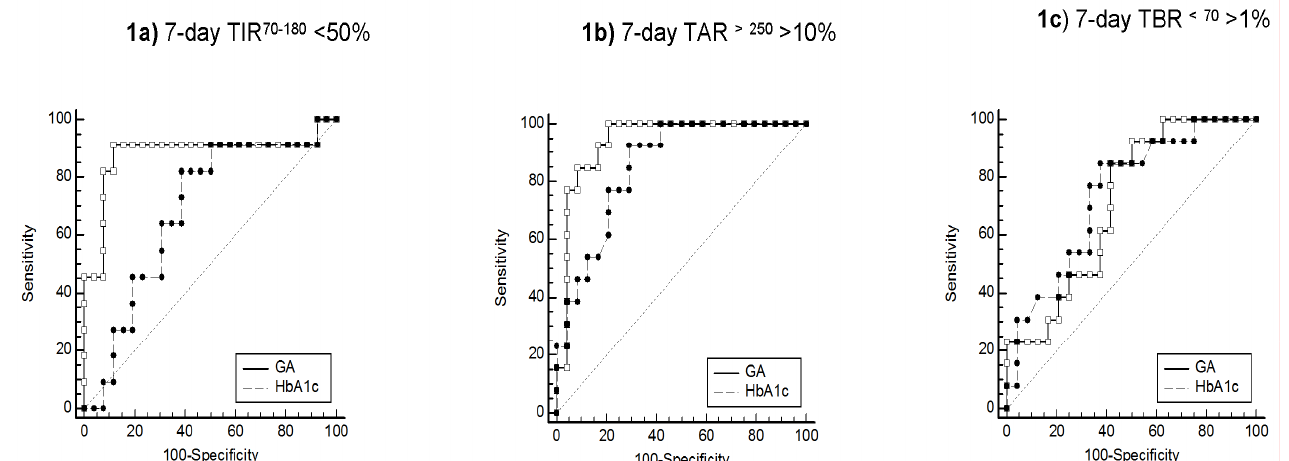
Figure 1. ROC curves of GA and HbA1c in diagnosing inadequate glycemic control using 7-day CGM-derived metrics as the reference standard. Table 2. Thresholds for GA and HbA1c in detecting a 7-day CGM-derived TIR 70–180 , TAR >250 , or TBR <70 in <50%, >10% and >1% of readings.